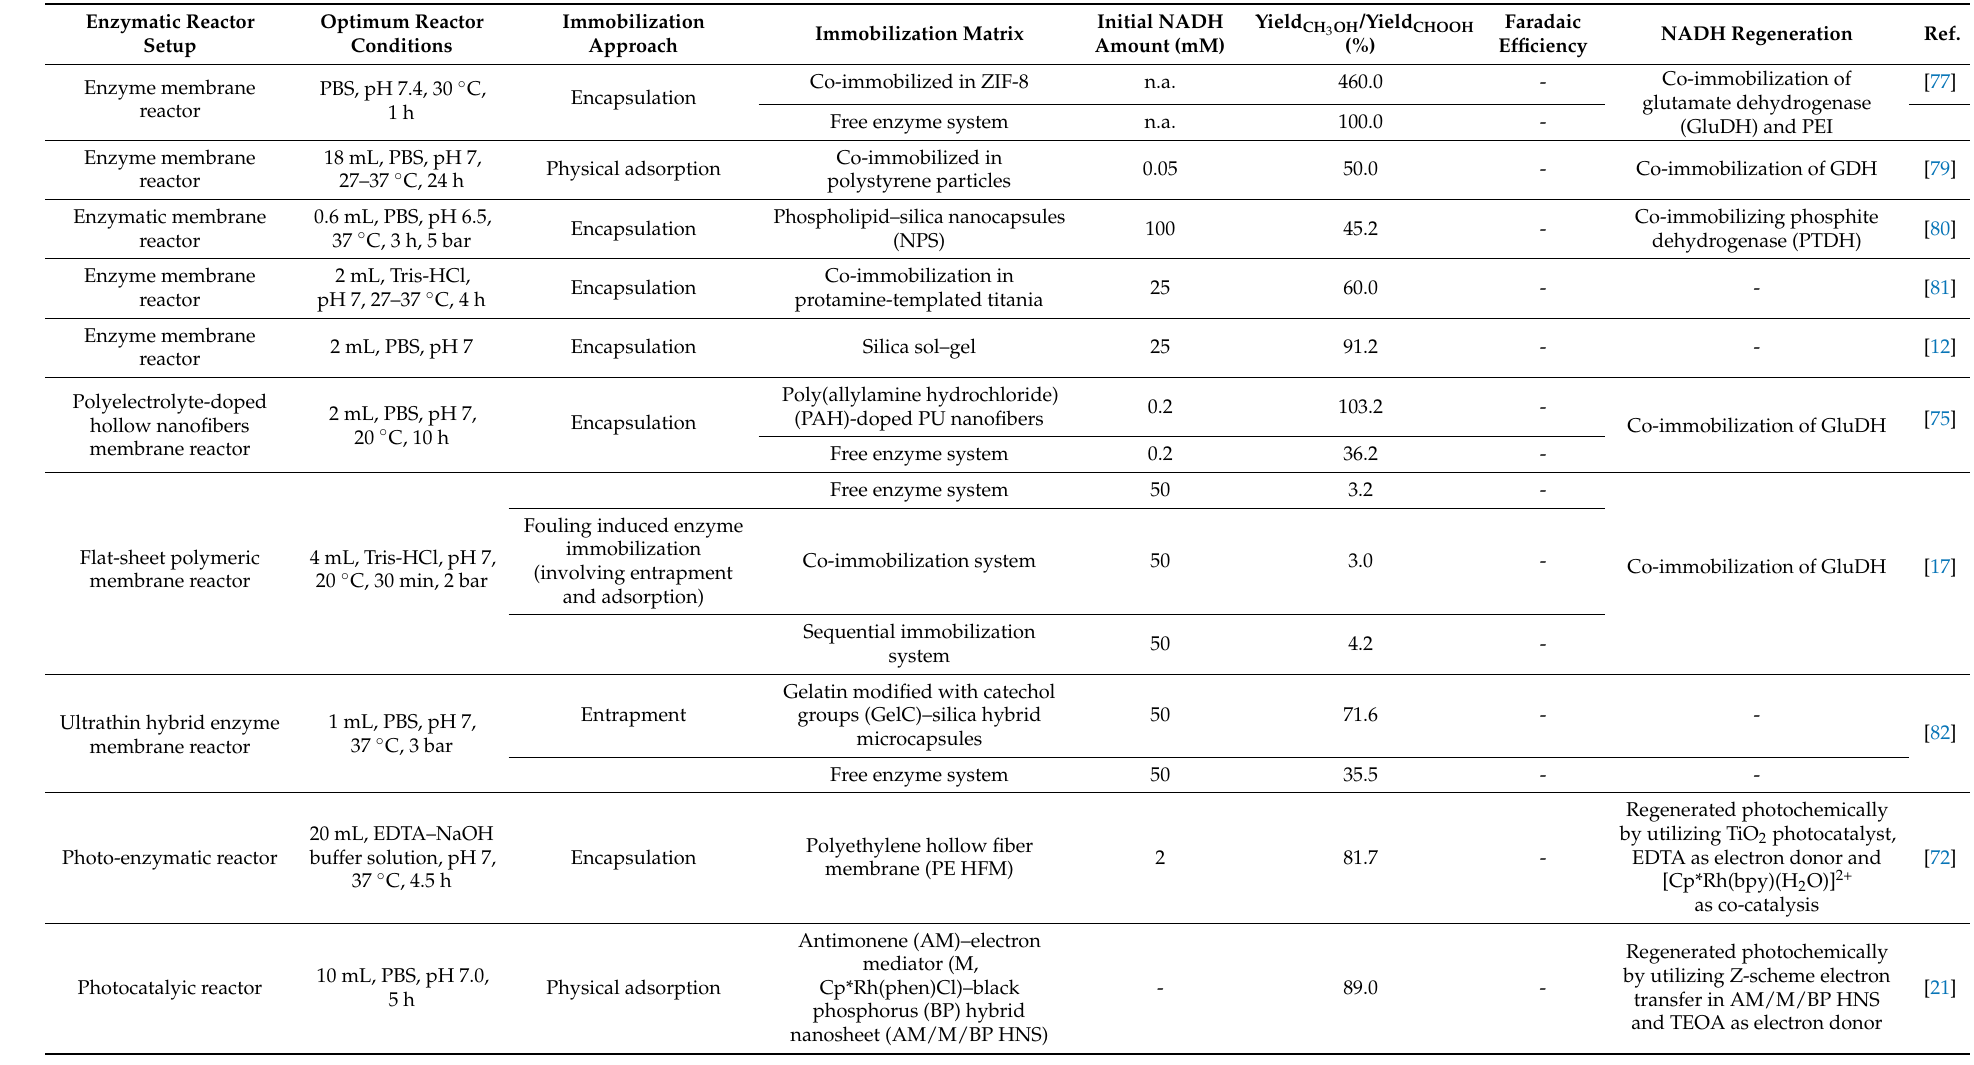
Table 2. Enzymatic reactor systems applied by researchers for catalyzing the reduction of CO 2 and their biocatalytic